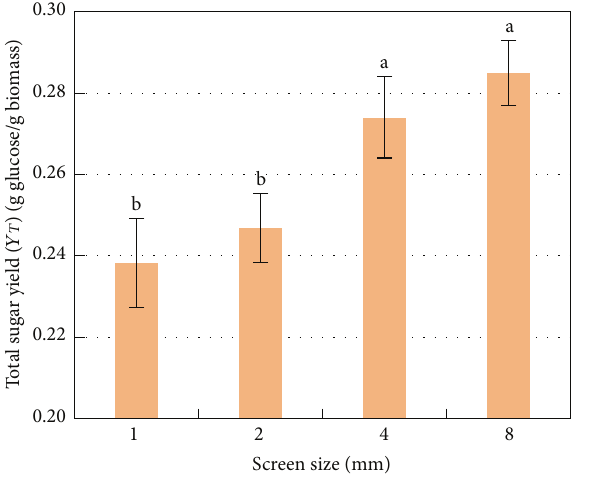
Figure 13: Effects of screen size on total sugar